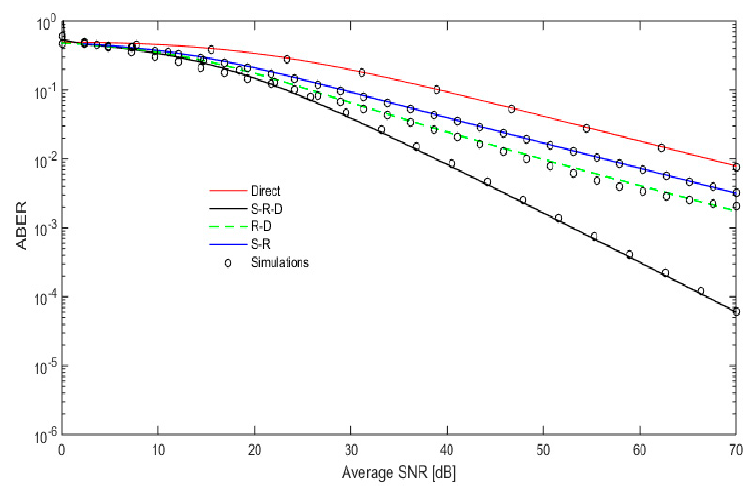
Figure 17. ABER vs. SNR of FSO over the G-G channel for strong turbulence with distance 400–600 m, number of relays = 2 and w z = 0.5 m.